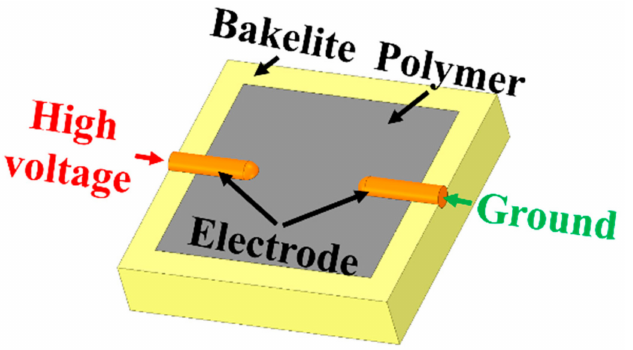
Figure 2. Dimensions and fabricated test jig for the surface discharge